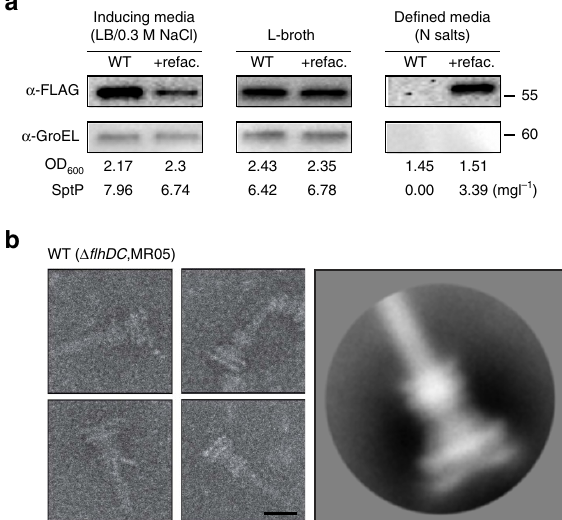
Figure 4 | Structural and functional analysis of the refactored T3SS. Data are shown for the complete refactored system (Fig. 1b, prg - org R5 and inv - spa R4 ) in the D SPI-1 strain background (MR27). ( a ) Cultures were grown in different media (Methods). The refactored system was induced with 10 m M IPTG and 10 m M AHL. The quantification of secreted proteins is described in Methods. Bacterial growth as OD 600 and secreted protein titre are noted at the time of sampling. The growth curves of each culture are shown in Supplementary Fig. 14. ( b ) Representative images of T3SS needle complexes isolated from Salmonella typhimurium LT2 DW01 (WT) with the flagella knockout are shown (MR05). The image on the right represents a class average from 129 individual particles (see Methods). ( c ) Same as part b , with the refactored SPI-1 ( prg-org R5 and inv-spa R4 ) in a D flhDC D SPI-1 background (MR30). The image on the right represents a class average from 158 individual particles. The scale bar indicates 50nm. The images of individual particles are shown in Supplementary Fig. 24. ( d ) Relative secretion is calculated at the band intensity of a secretion assay for the refactored SPI-1 divided by the intensity obtained from the wild-type (Methods). A secretion assay was performed 6h after induction. The following concentrations of inducer were added to the culture: IPTG (0, 0.1, three replicates performed on different days. ( e ) The impact of delays between the expression of prg - org R5 and inv - spa R4 are shown (MR27). For the green and red lines, one inducer is added at t ¼ 0 and then the secretion titre is measured at t ¼ 6h. The relative secretion is calculated as described in part d . For the black line, both inducers are added at the indicated time point and the secretion measurement is made at t ¼ 6h. Either inducer is added to a concentration of 10 m M. Data shown are the average of three experiments performed on different days and the error bars represent the